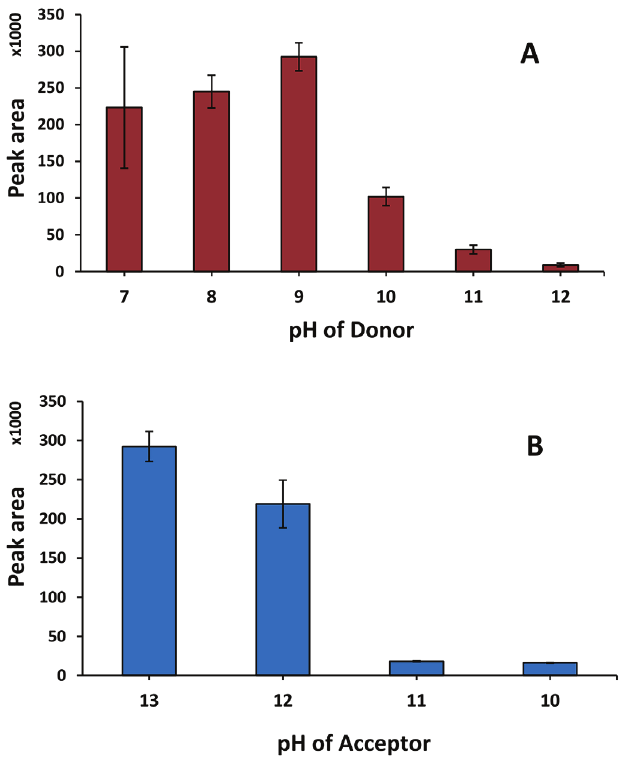
FIGURE 3 - Effect of (A) pH of donor solution, and (B) pH of acceptor solution on EME efficiency (extraction conditions; concentration in donor: 1 µg/mL, SLM: 1-octanol, pH, time of extraction: 10 min and voltage: 40